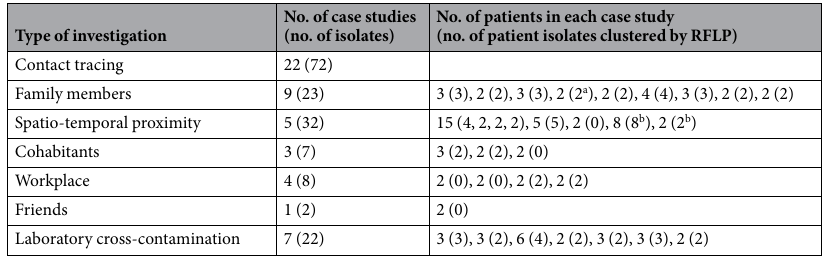
Table 1. Case studies of molecular epidemiology investigations. a One of the isolates within the cluster presented two additional bands in RFLP. b One of the isolates within the cluster presented an additional band in RFLP. RFLP: restriction fragment length